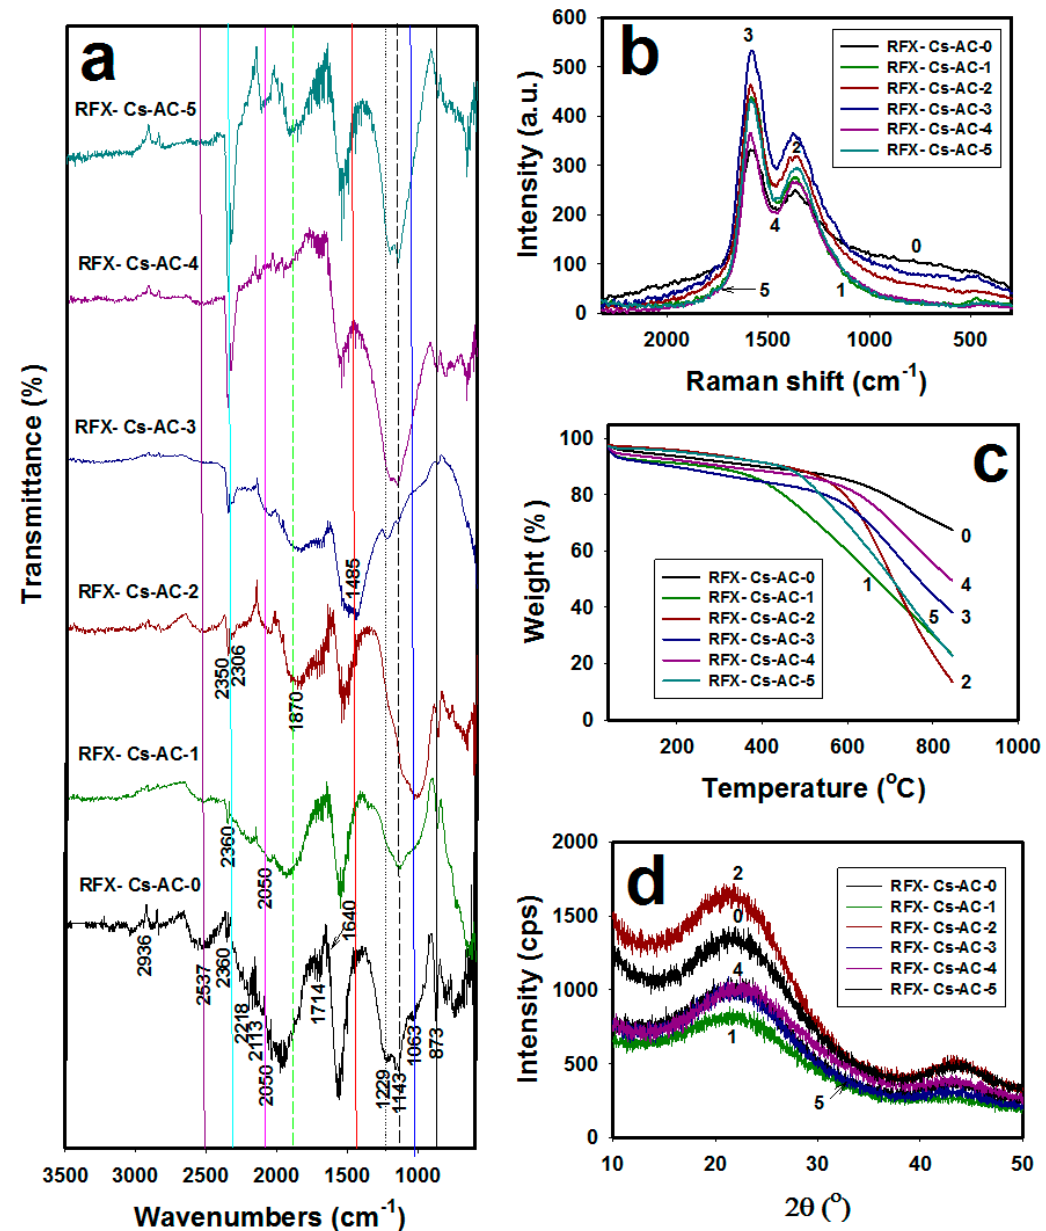
Figure 1. ( a ) FTIR spectra, ( b ) Raman spectra, ( c ) TGA thermograms and ( d ) XRD patterns of RFX-Cs-AC samples. Curve numbers from 0 to 5 correspond to the suffix numbers of RFX-Cs-Ac samples.